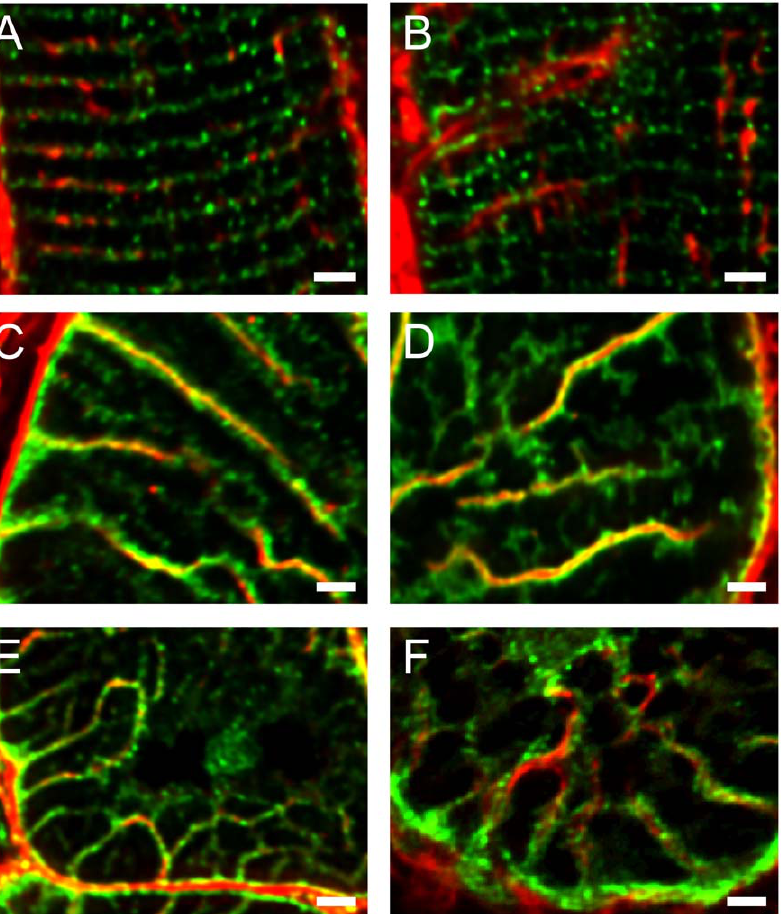
Figure 4. Sarcolemmal protein labelling with WGA in normal and failing human cardiac myocytes. Panels are arranged so that the left column corresponds to normal and the right column diseased tissue. A and B show longitudinal sections of control and diseased myocytes respectively, labelled for DHPRs (green) and WGA (red). The DHPR labelling is more continuous across the cell than the WGA label. Panels C and D show transverse images labelled for NCX (green) and WGA (red). In control myocytes ( C ), finer tubules containing only the NCX label can be seen to connect to larger spoke like tubules containing both labels. Diseased ( D ) myocytes have similar labelling pattern but many connections between larger tubules appear broken. Panels E and F show transverse sections labelled for Cav3 (green) and WGA (red). ( E ) Again, finer tubules labelled with only Cav3 connect larger tubules containing both labels. Diseased myocytes ( F ) have similar labelling pattern but with a reduction in fine Cav3 labelling between larger tubules. Images are z projections of 4 slices with z depth of 0.8 m m from deconvolved image stacks. Scale bars are 2 m m.